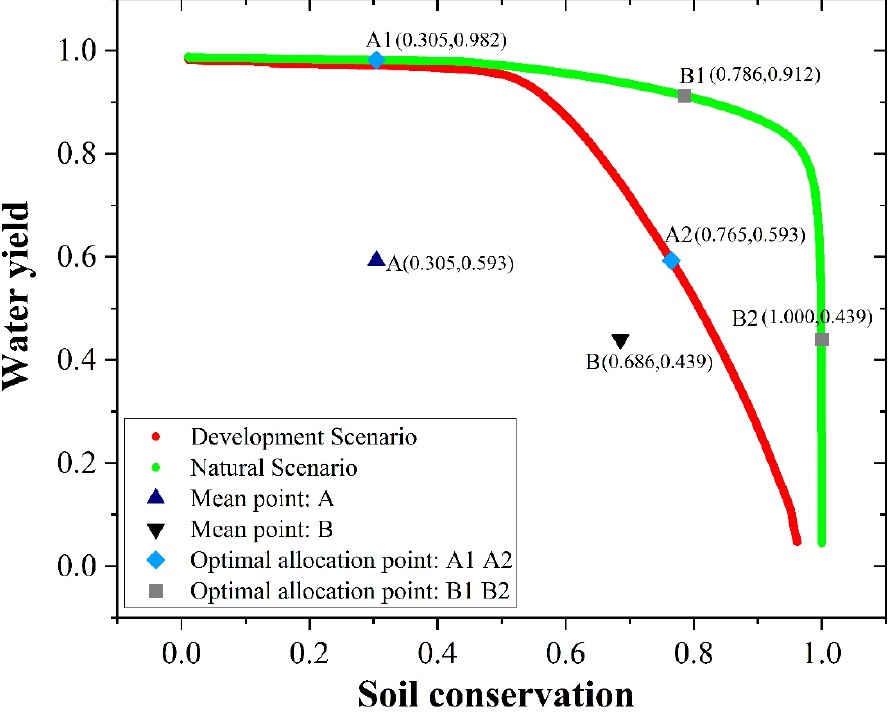
Figure 9. Trade-off curve between soil conservation and water yield under different scenarios.